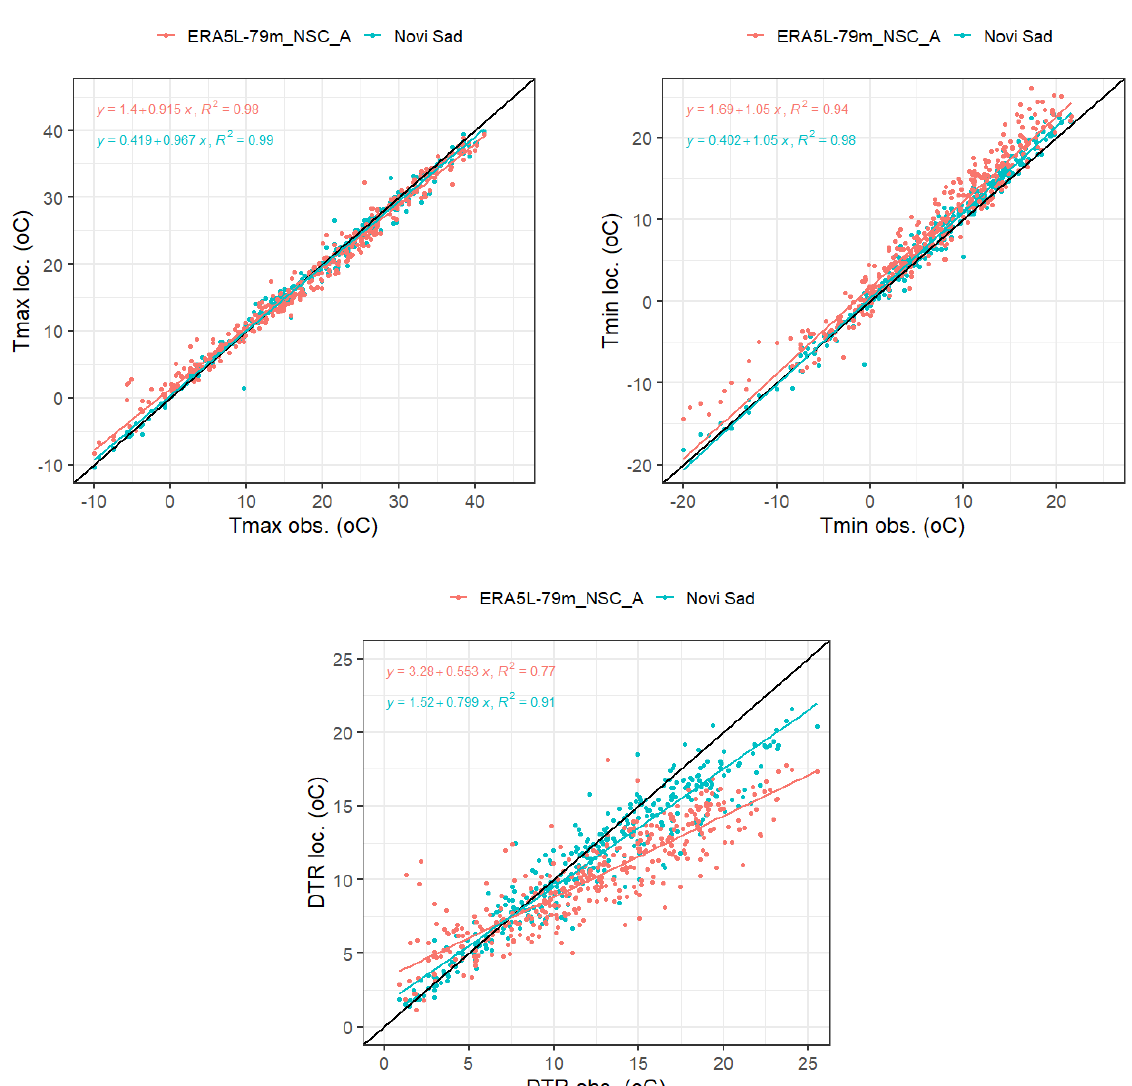
Figure 9. Scatter diagram of the T max , T min , and DTR during the year 2017 observed on 79m_NSC_A (obs.) AWS in respect to Novi Sad climatological station and ERA5-Land reanalysis for 79m_NSC_A (loc.). Table 5. Average of standard deviation (SD), centered root-mean-square error (RMSE), and Pearson correlation coefficient (CC) for T max , T min and DTR for five regionally representable AWSs, corre- sponding ERA-Land data, and closest climatological station.